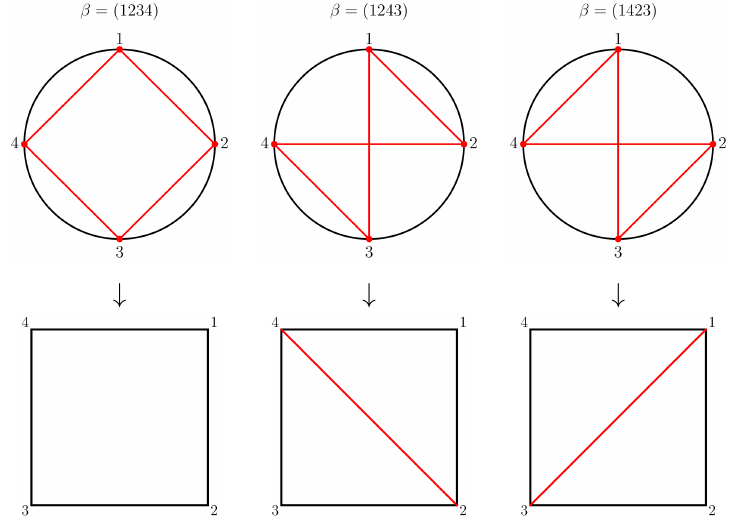
Figure 15 . Partial triangulations in the definition of positive regions ∆ 4 ( β )